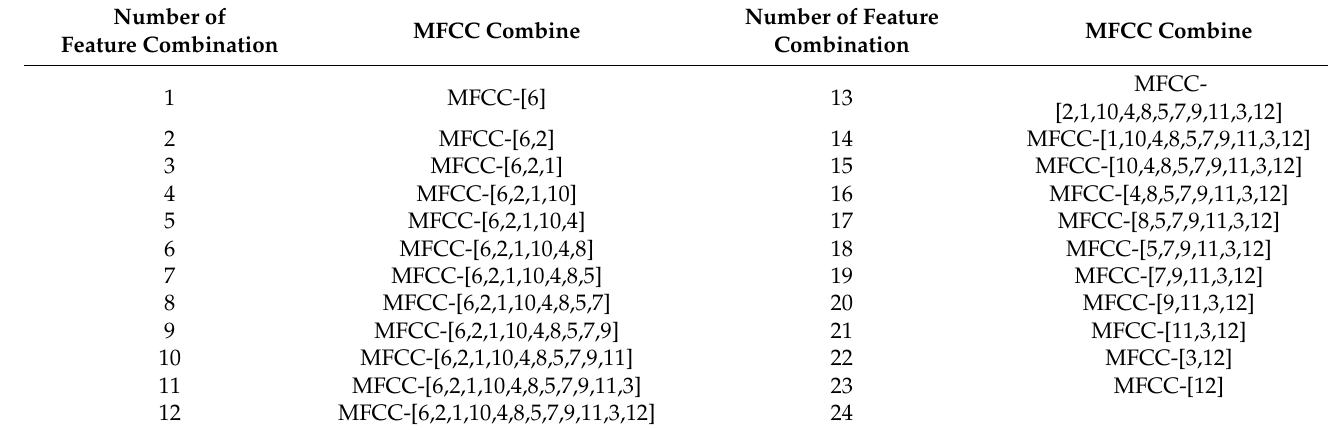
Table 5. Mel cepstrum coefficient combination and combination number.